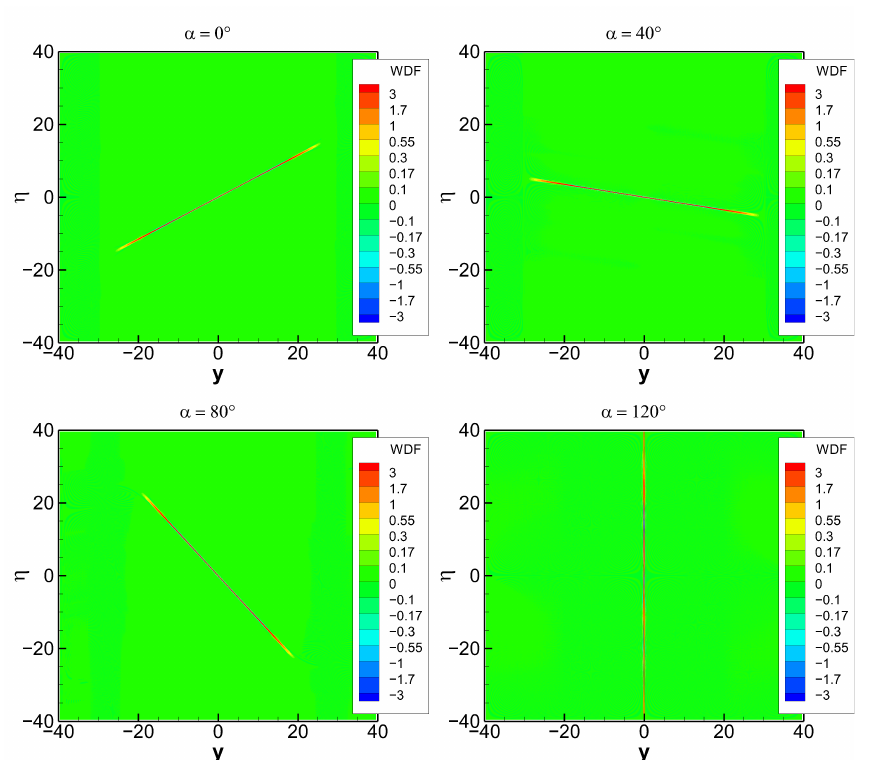
Figure 4. WDF ρ W α of function ˜ ψ α ( y ) in rotated coordinates ( y , η ) . The rotation angle α takes the values of 0 ◦ , 40 ◦ , 80 ◦ , and 120 ◦ .